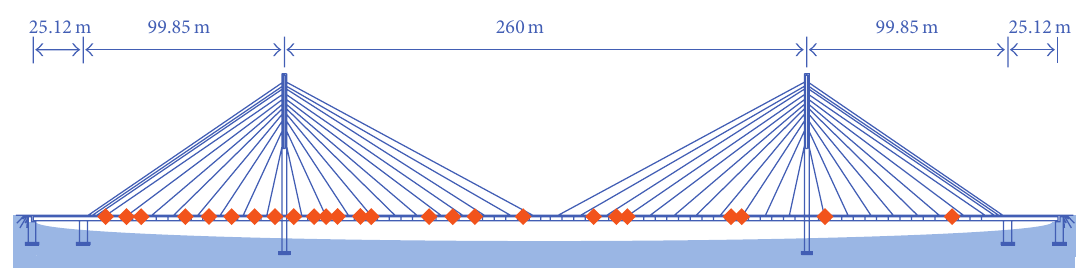
Figure 4: The optimal sensor configuration extracted by GA with the